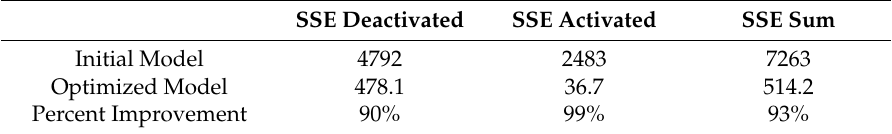
Table 3. Sum of squared errors (SSE) for initial (non-optimized) and optimized